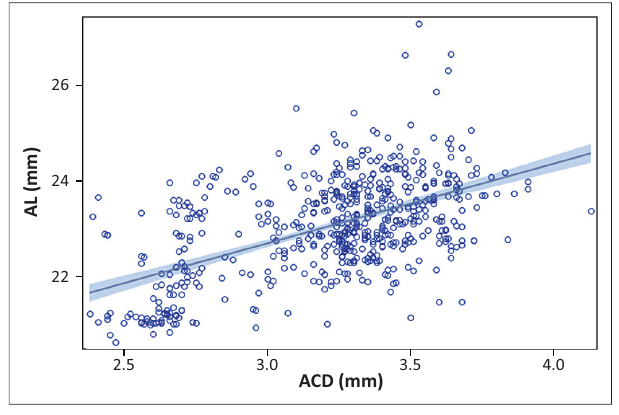
The regression line is axial length = 17.68 + 1.67 (anterior chamber depth). AL, axial length; ACD, anterior chamber depth. FIGURE 2: Scatter plot showing the correlation (and 95 % confidence interval of the regression line) between the axial length and anterior chamber depth ( R 2 = 0.306, r = 0.66, p = 0.000).